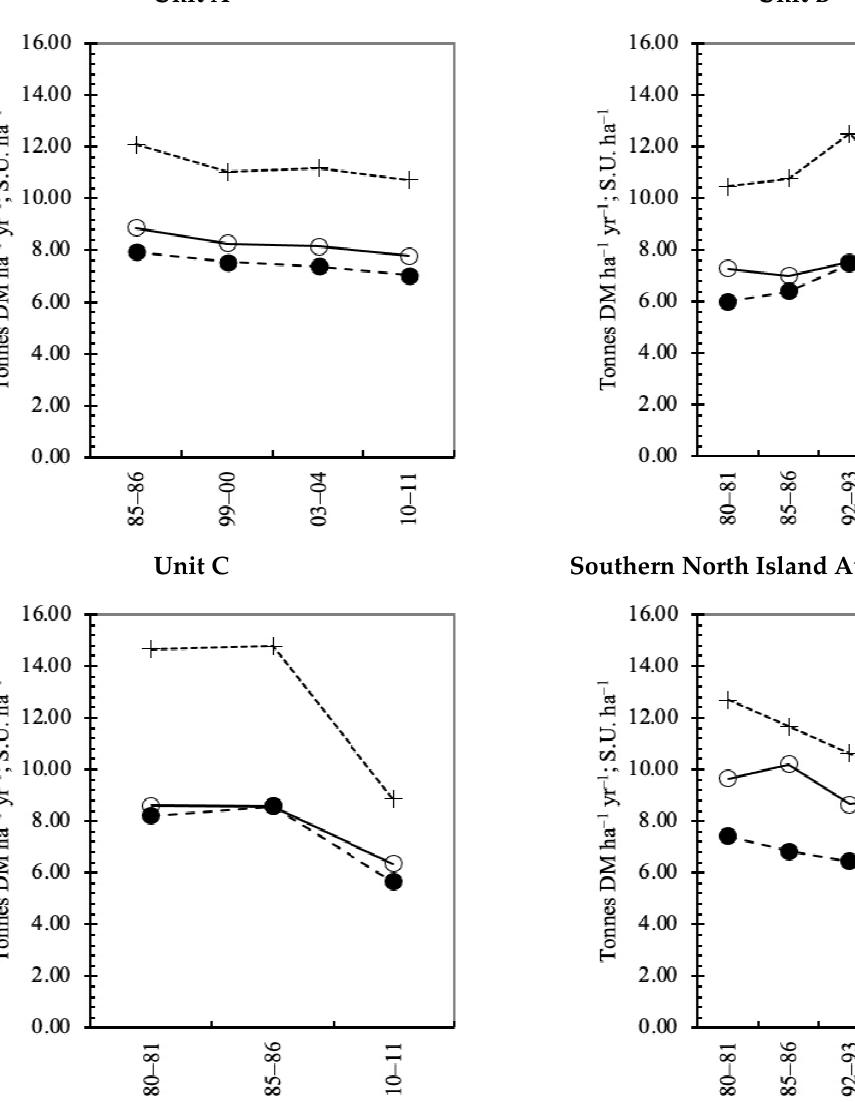
Figure 1. Annual herbage supply ( ) from GROW, feed demand ( • ) from MEB, and animal stock units (SU) per hectare (+) on the case-study farms and Average System (B+LNZ Class IV, medium slope, New Zealand southern North Island hill country sheep and beef cattle production system) from the 1980s to 2010–2011. Table 3. Change in feed demand and herbage (feed) supply on the Average System and case-study farms between the 1980s and 2010–2011.